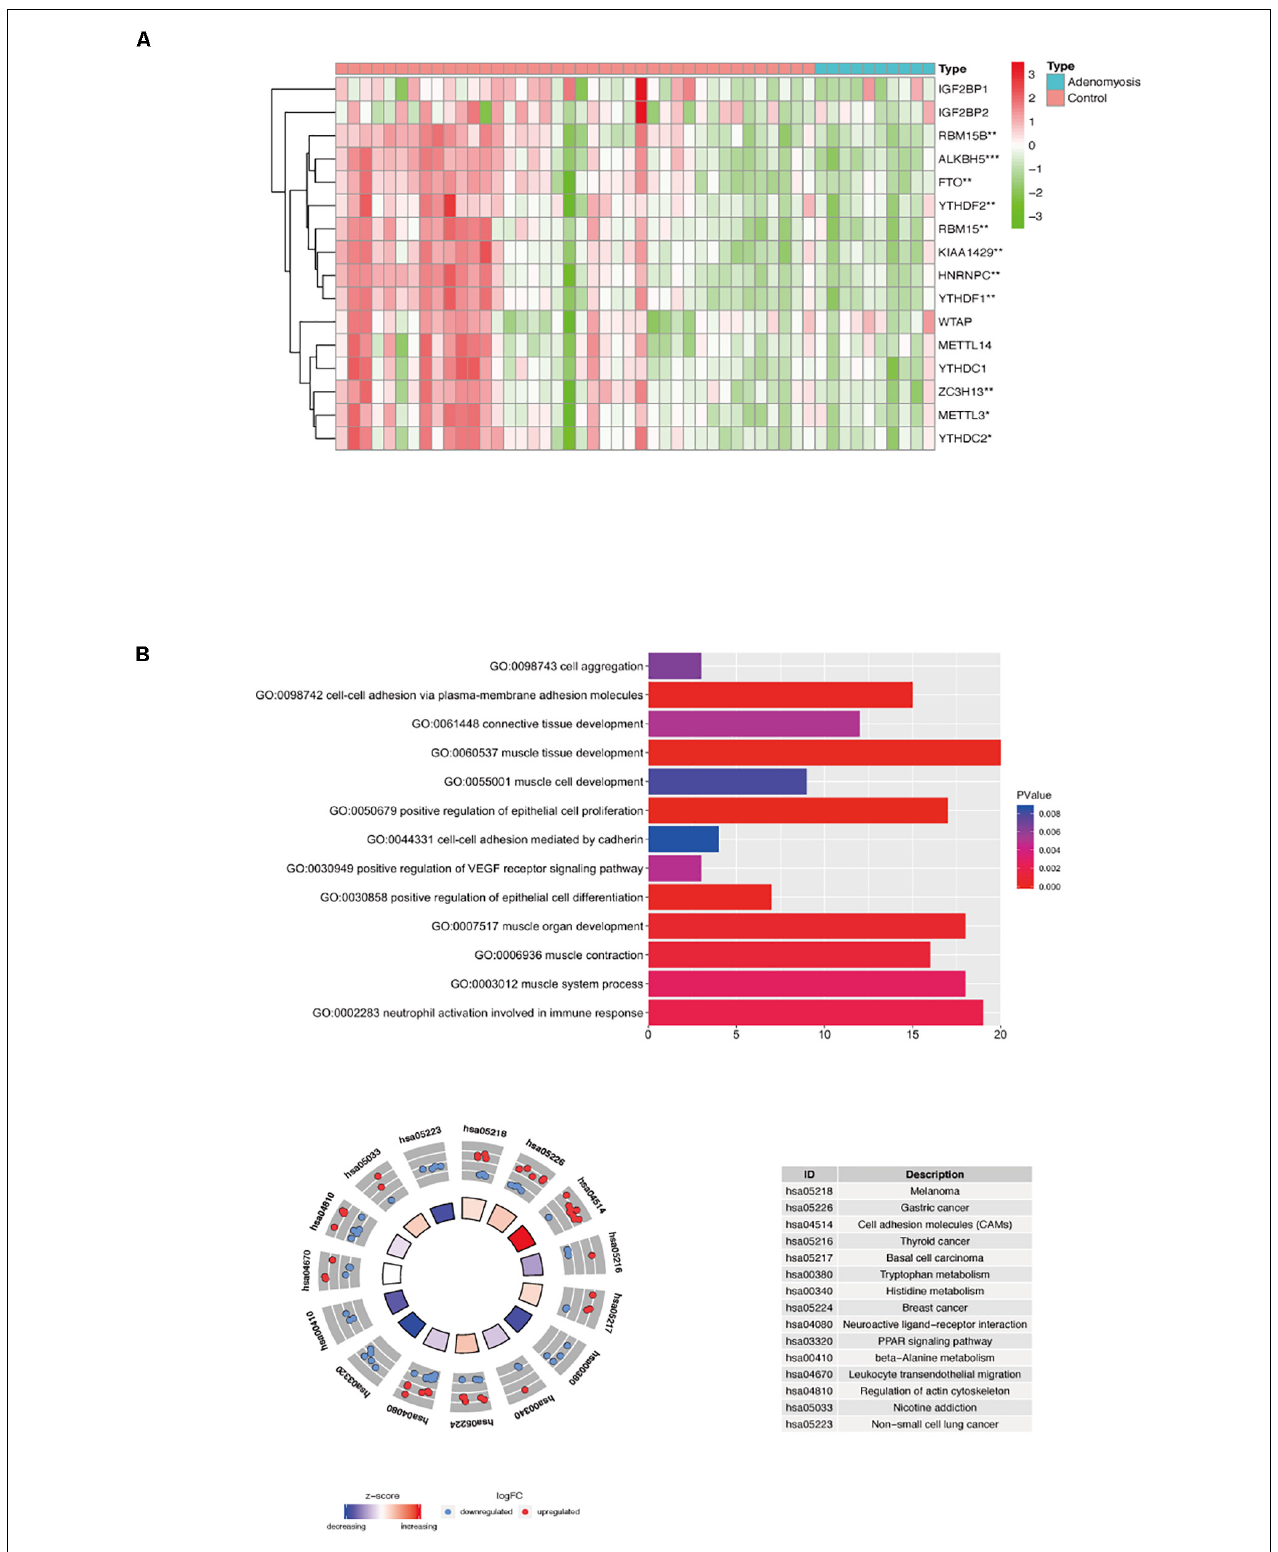
FIGURE 5 | The expression of m 6 A RNA methylation regulators and the functional enrichment of DEGs in the myometrium of women with and without adenomyosis. (A) The expression levels of sixteen m 6 A RNA methylation regulators in the myometrium (10 women with adenomyosis and 40 without adenomyosis). (B) Functional enrichment of the DEGs of myometrium using GO terms of biological processes (upper) and KEGG pathway (lower).